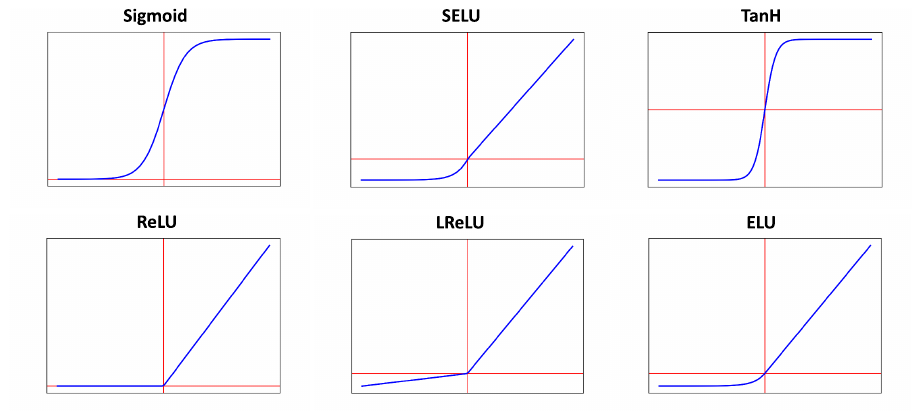
Figure 2. Sigmoid, Scaled Exponential Linear Unit (SELU), Hyperbolic tangent (TanH), Rectifier Linear Unit (ReLU), Leaky ReLU (LReLU), and Exponential Linear Unit (ELU) activation